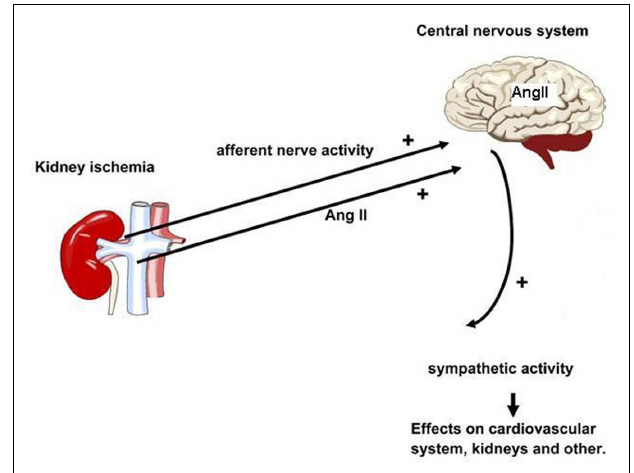
FIGURE 1 | Schematic representation of the kidney involvement in the pathogenesis of sympathetic hyperactivity. Minimal kidney damage, not necessarily affecting kidney function, results in area(s) of ischemia.This results in increased afferent nerve activity and increased levels of AngII in plasma and CNS. Increased central sympathetic outflow affects many organs also including the cardiovascular system. In addition, AngII may enhance sympathetic activity on the peripheral